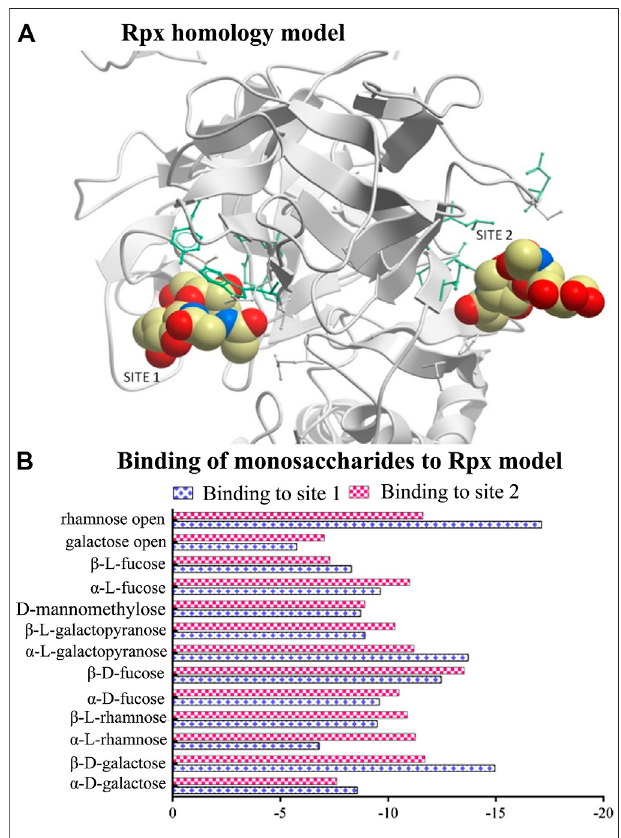
FIGURE1| Modeling ofriproximin ’ sstructure and itsaf fi nity forselected monosaccharides. (A) Represents a homology model of the B-chain of Rpx showing two sugar binding sites. The model was built from the closest homology template derived from the Protein Data Bank (PDB 2VLC) using ICM-Pro v3.79 software (Molosoft LLC, San Diego CA). (B) Represents a pro fi le of energy scores obtained from docking experiments. In total, 13 monosaccharides were docked to the two binding sites of Rpx. Low energy scores indicate high af fi